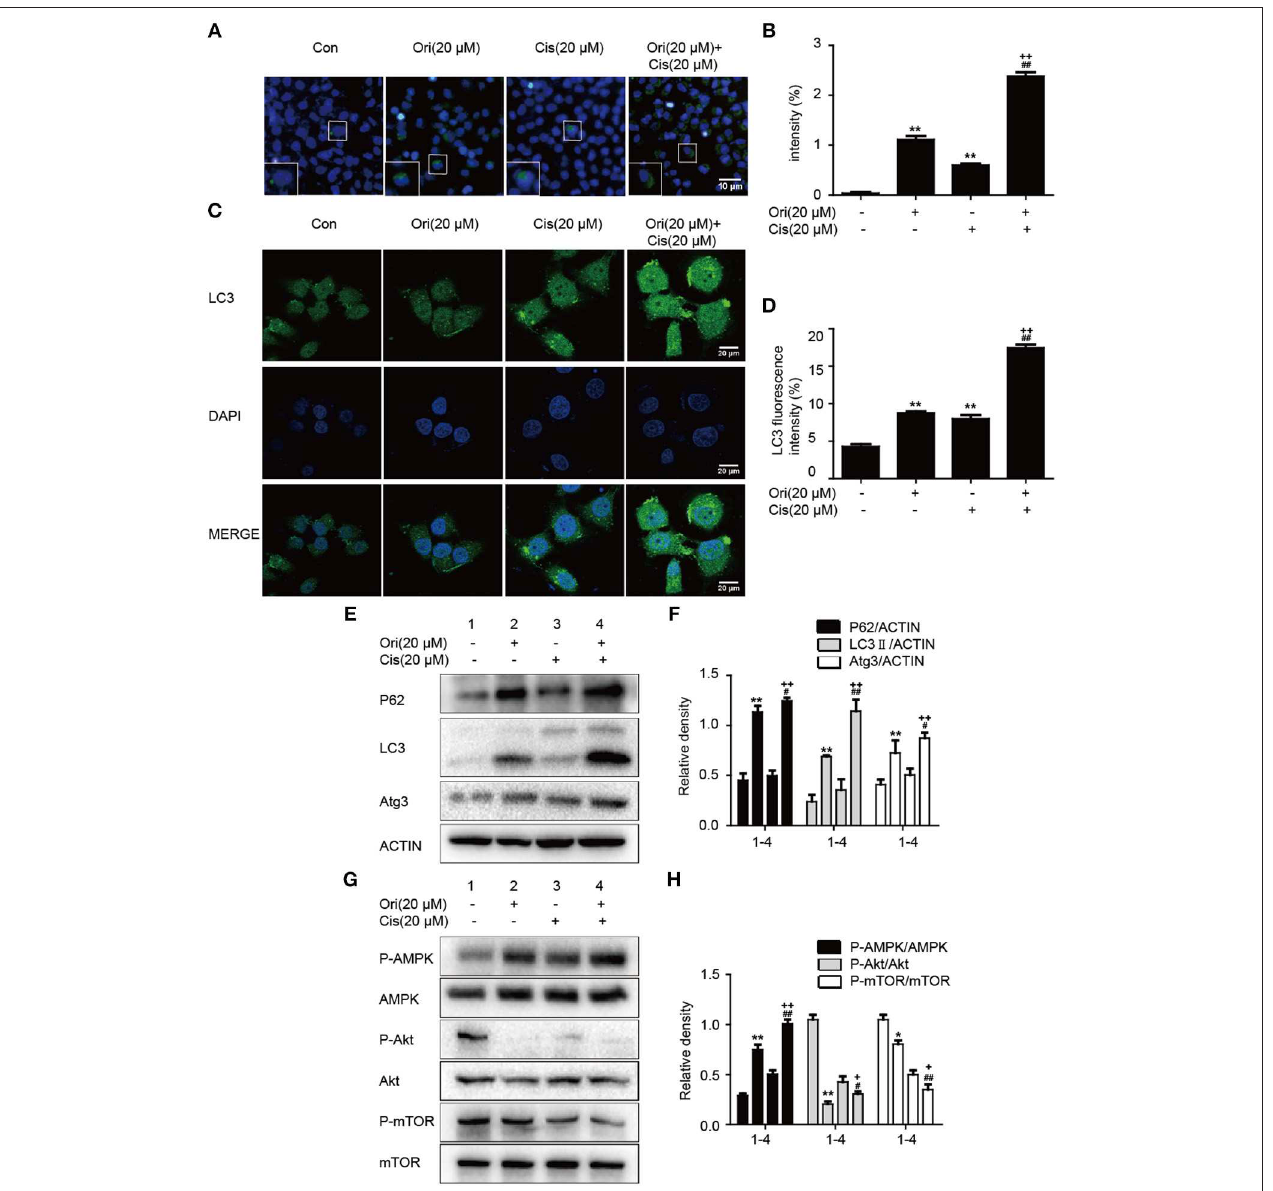
FIGURE 4 | Ori enhances chemotherapeutic sensitivity through the modulation of autophagy and AMPK/Akt/mTOR pathways. A549 cells were exposed to Ori (20 µ M) in the absence or presence of cisplatin (20 µ M) for 18h. (A,B) Cells were stained with an autophagosome specific green reagent and examined by fluorescence microscope. The green fluorescence intensity was analyzed by Image J. Scale bars: 10 µ M. (C,D) Cells were stained with LC3 and DAPI and images were captured with confocal microscope. The LC3 fluorescence intensity was analyzed by Image J. Scale bars: 20 µ M. (E–H) Western blots and statistical results showed the protein levels of P62, LC3, Atg3, P-AMPK, AMPK, P-Akt, Akt, P-mTOR, and mTOR. The results showed the average of three independent experiments. * p < 0.05 and ** p < 0.01 vs. the control group. # p < 0.05 and ## p < 0.01 vs. the Ori group. + p < 0.05 and ++ p < 0.01 vs. the Cis